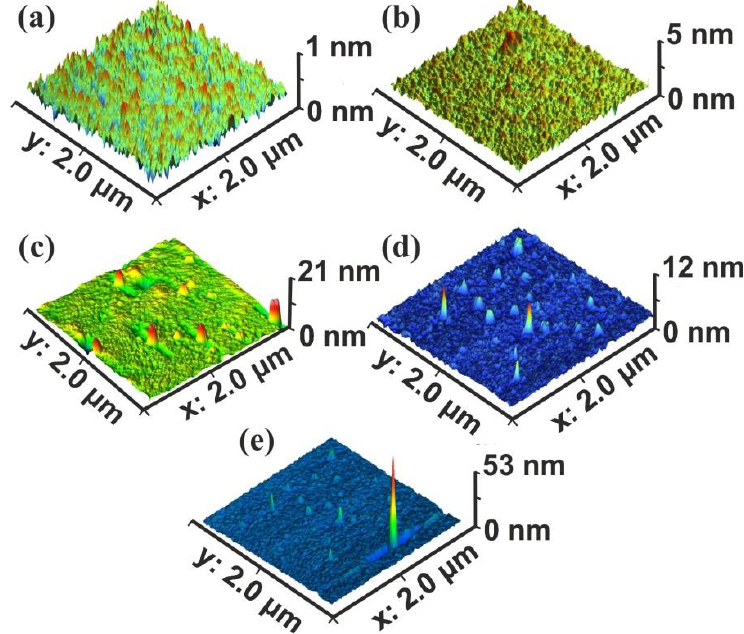
Figure 2. Atomic force microscopy (AFM) surface image of polyacrylamide (PAM) layers. Scan area 2 × 2 µ m 2 , laser fluence 250 J m − 2 per pulse: ( a ) non-irradiated PAM layer; ( b ) irradiated PAM layer with 100 laser pulses (lp), 25 kJ m − 2 ; ( c ) 200 lp, 50 kJ m − 2 ; ( d ) 10 3 lp, 250 kJm − 2 ; ( e ) scan area 2.3 × 2.3 µ m 2 , 10 3 lp, 250 kJ m − 2 . The surface morphology is area size-dependent.